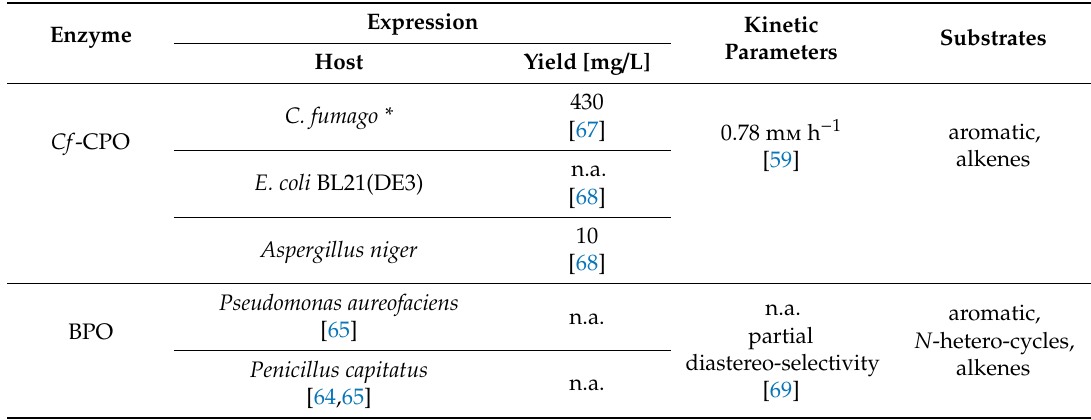
Table 1. Enzymological properties of heme-dependent haloperoxidases (* original host).